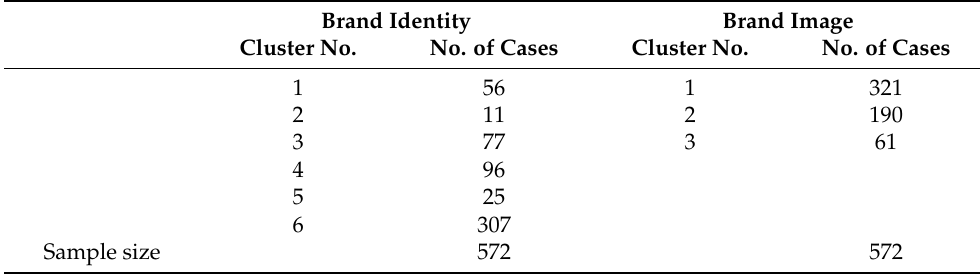
Table 2. Number of cases (wineries) in each of the winery brand identity and brand image